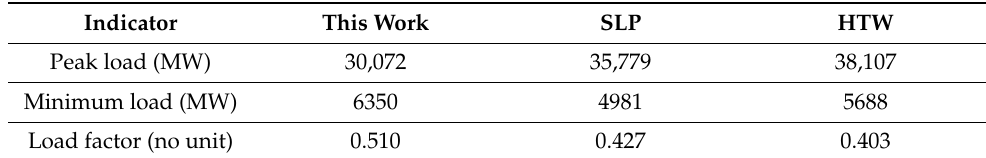
Table 3. Comparison of selected indicators over a full year between simulation, German standard load profile (SLP), and the University of Applied Sciences Berlin (HTW). The load factor describes the relation of average load to peak